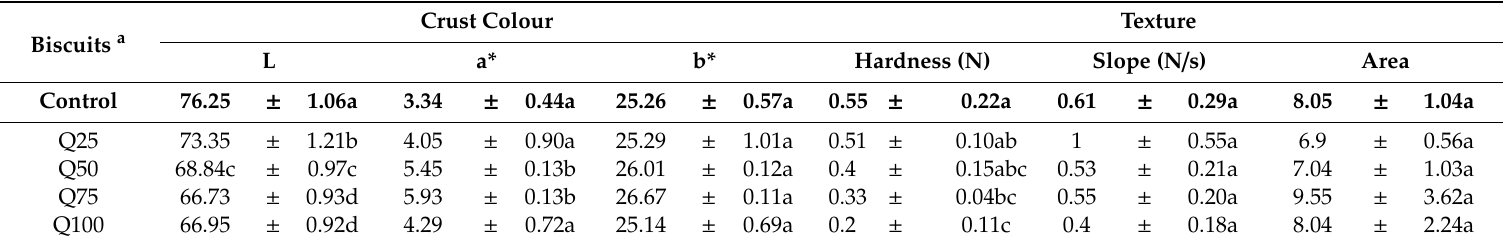
a Within columns, values ( n = 3) with the same letter do not di ff er significantly from each other according to LSD test ( p <